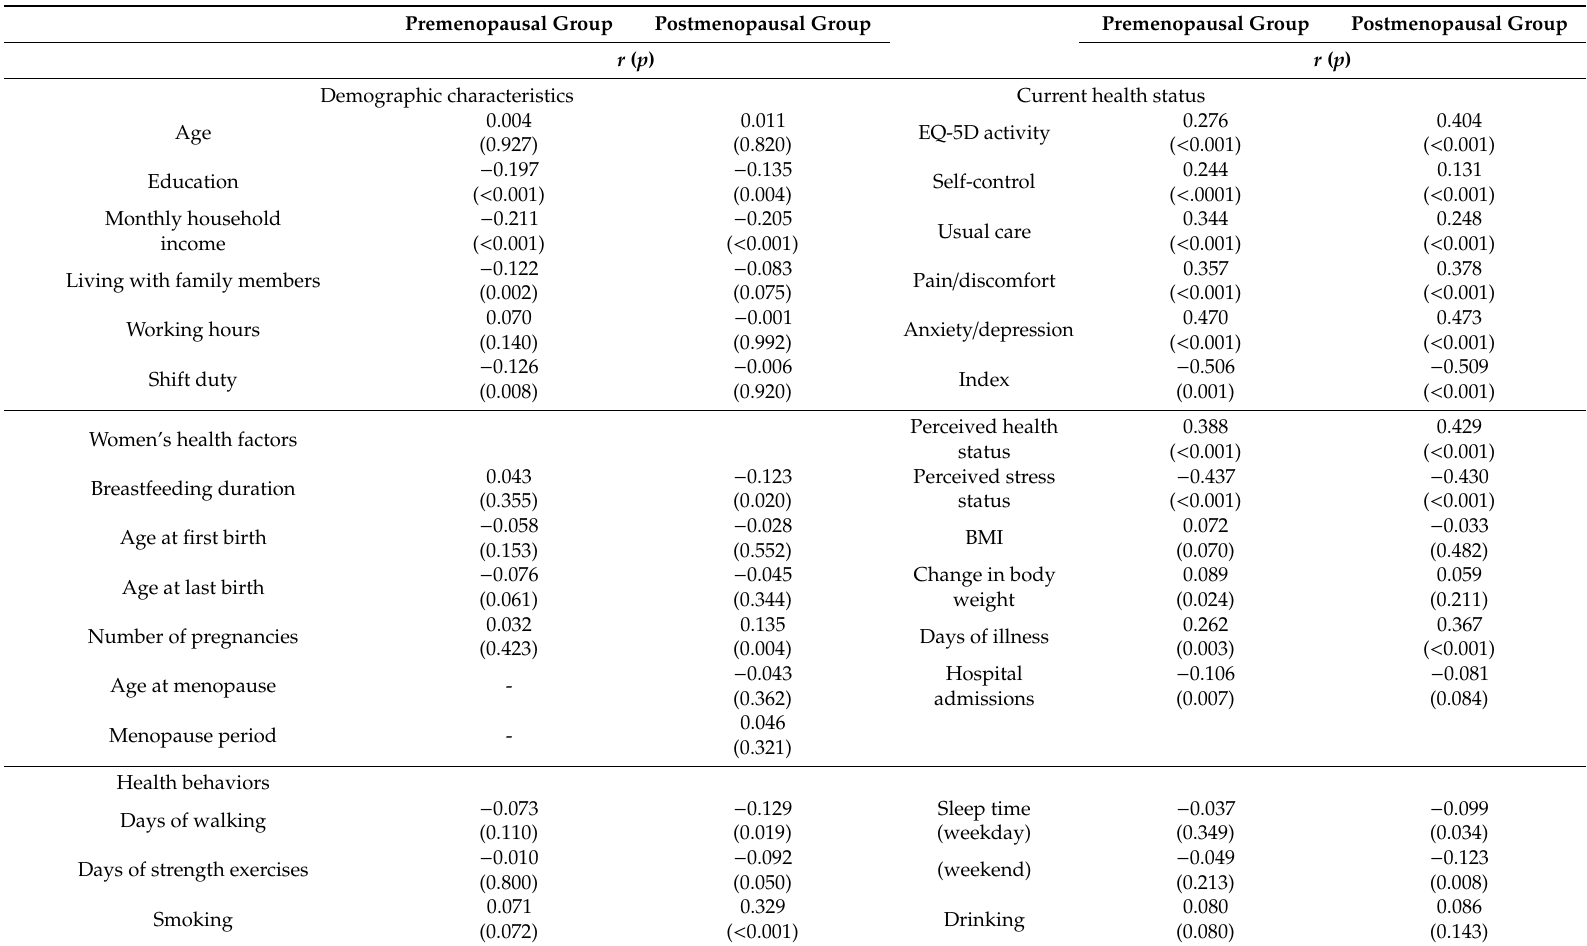
Table 3. Correlations between the depressive symptoms and study